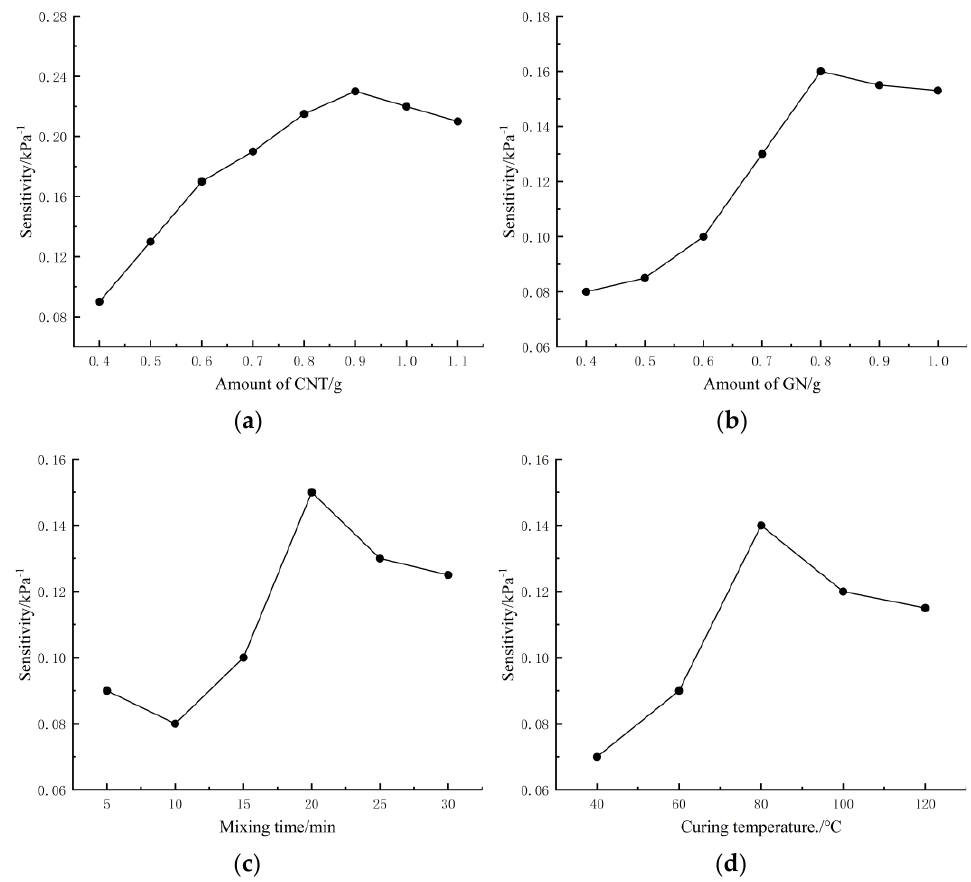
Figure 1. Effect of individual factors on sensor sensitivity. ( a – d ) are the effects of CNT, GN, mixing time, and the curing temperature on sensitivity, respectively. Table 1. Values and levels of chosen variables for central composite design.